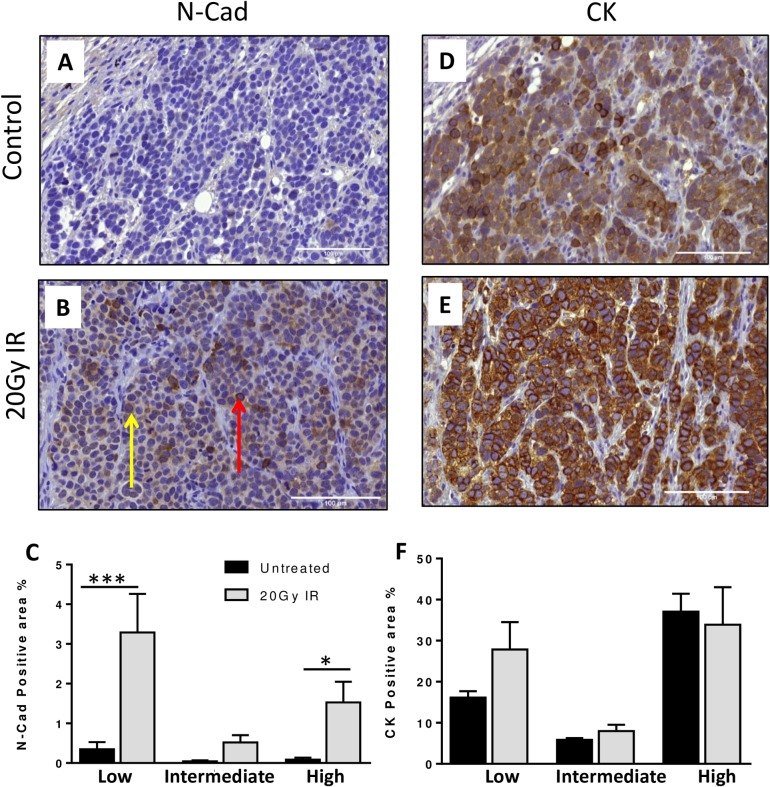
Increased N-Cadherin staining in irradiated tumours.The mesenchymal marker N-Cadherin (N-Cad) (A&B) and the epithelial marker cytokeratin (CK) (D&E) were analysed in all untreated and all 20Gy irradiated tumour sections. Quantitative assessment ([C] N-Cad, [F] CK) by Positive Pixel analysis of stained tissue sections. Staining was quantified as low, intermediate or high in the viable tumour area of untreated (black bars) vs irradiated tumours (grey bars). Red arrow indicates an example of a highly stained cell, yellow arrow indicates an area of low staining. Very low level background staining was discounted. ***p = <0.001 *p = <0.05.